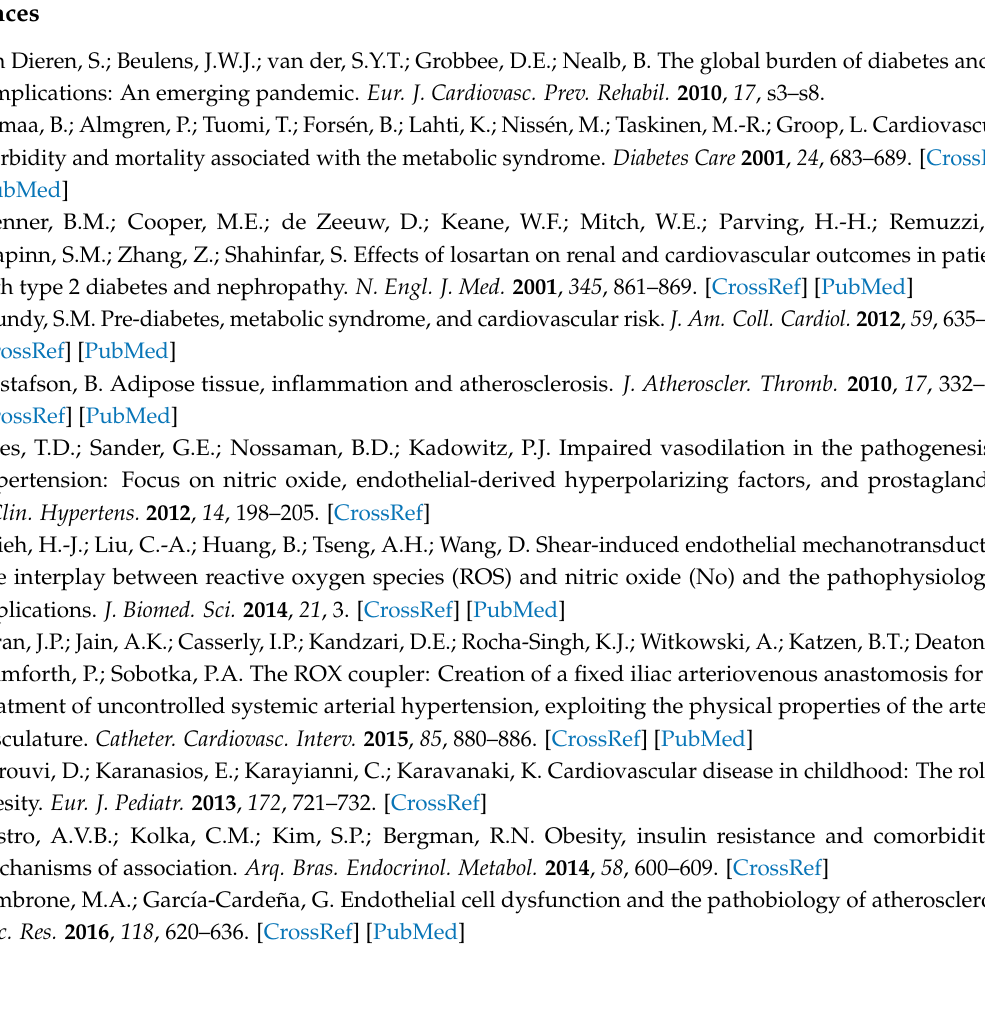
Table S3: Composition of fats, proteins and carbohydrates of the normal diet (ND) and high fat high carbohydrate diet